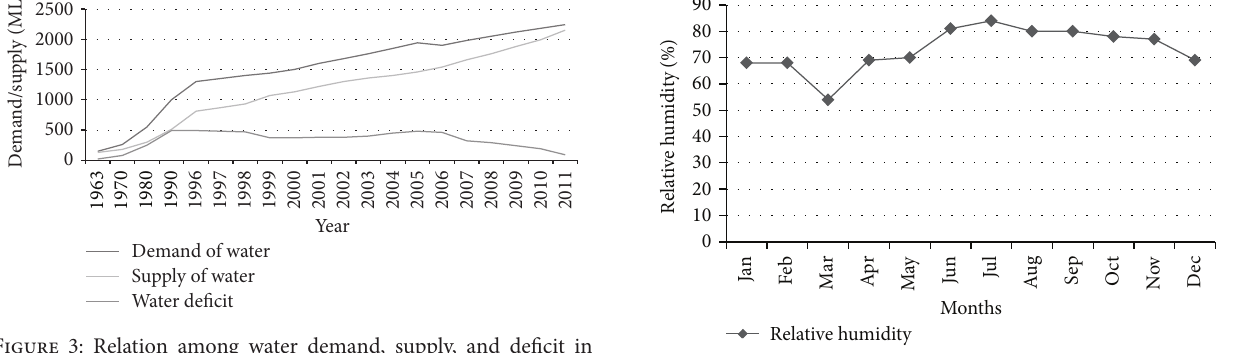
Figure 6: Monthly average relative humidity (%) in Dhaka City.